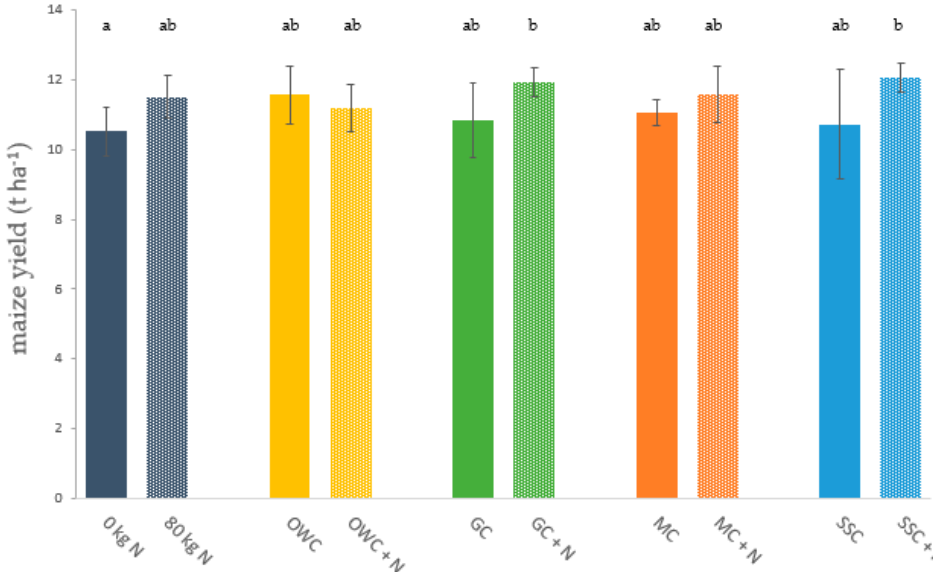
Figure 1. Maize yield (mean ± SD; n = 4). Columns with the same lowercases letters are not significantly different ( p ≤ 0.05) between treatments. Control (0 kg N), 80 kg mineral N ha − 1 (80 kg N), urban organic waste compost (OWC), green waste compost (GC), farm yard manure compost (MC), sewage sludge compost (SSC), + N application of 80 kg N ha − 1 .